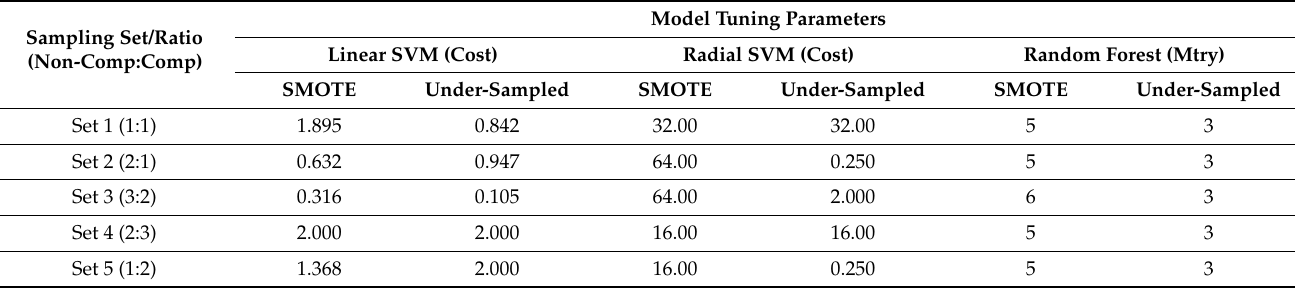
Table 3. Final model tuning parameters. For linear and radial SVM, the cost parameter represents the optimal penalty threshold for misclassifications. For the random forest models, mtry, the optimal number of randomly selected predictor variables is reported (SVM = Support Vector Machine, SMOTE = Synthetic Minority Oversampling